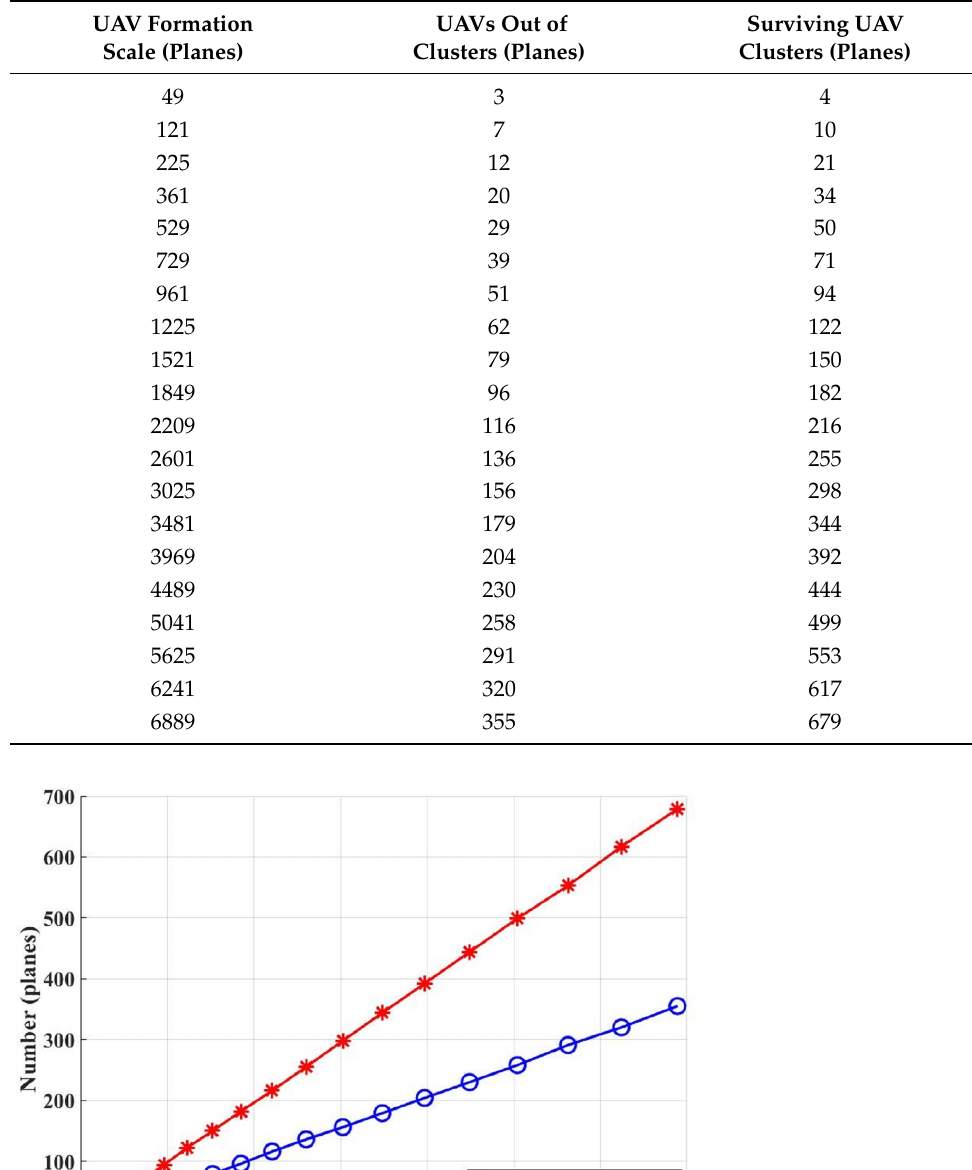
Table 3. Simulation results of UAV formations with 85% fight loss.